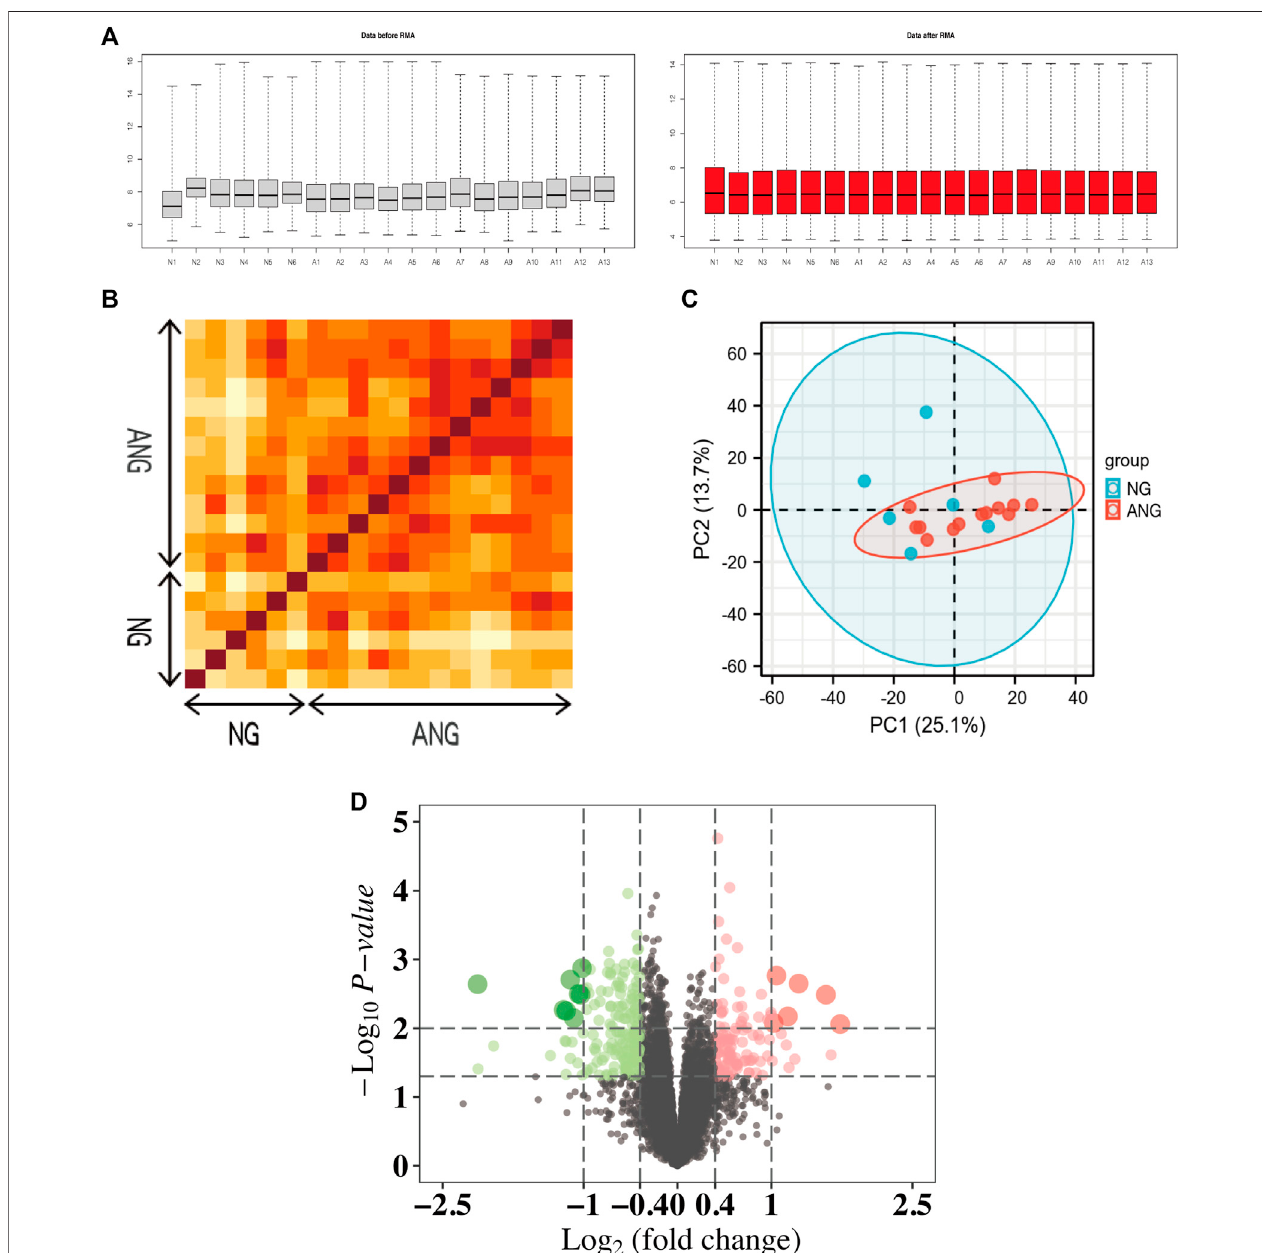
FIGURE 1 | Normalization and repeatability analysis of the dataset. (A) RMA algorithm normalization of samples from the GSE132651 dataset. Left: data before RMA; right: data after RMA. (B) Pearson ’ s correlation analysis of NG and ANG samples from the GSE132651 dataset. The color re fl ects the intensity of the